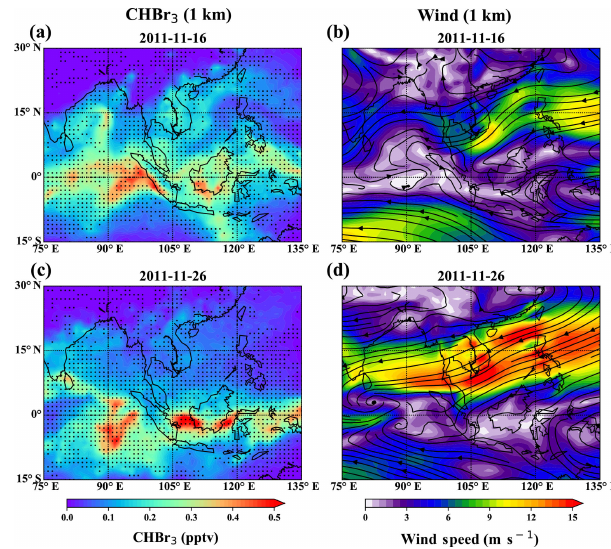
Figure 3. Same as Fig. 2, but for the SHIVA case.